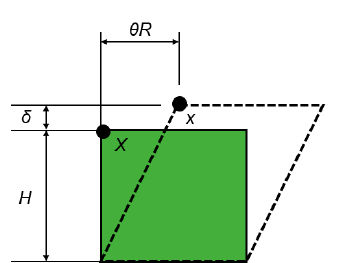
Figure 3. Original and deformed configuration of a material element subjected to axial and shear strains resulting from axial and torsional displacements δ and θ . Adapted from [45].